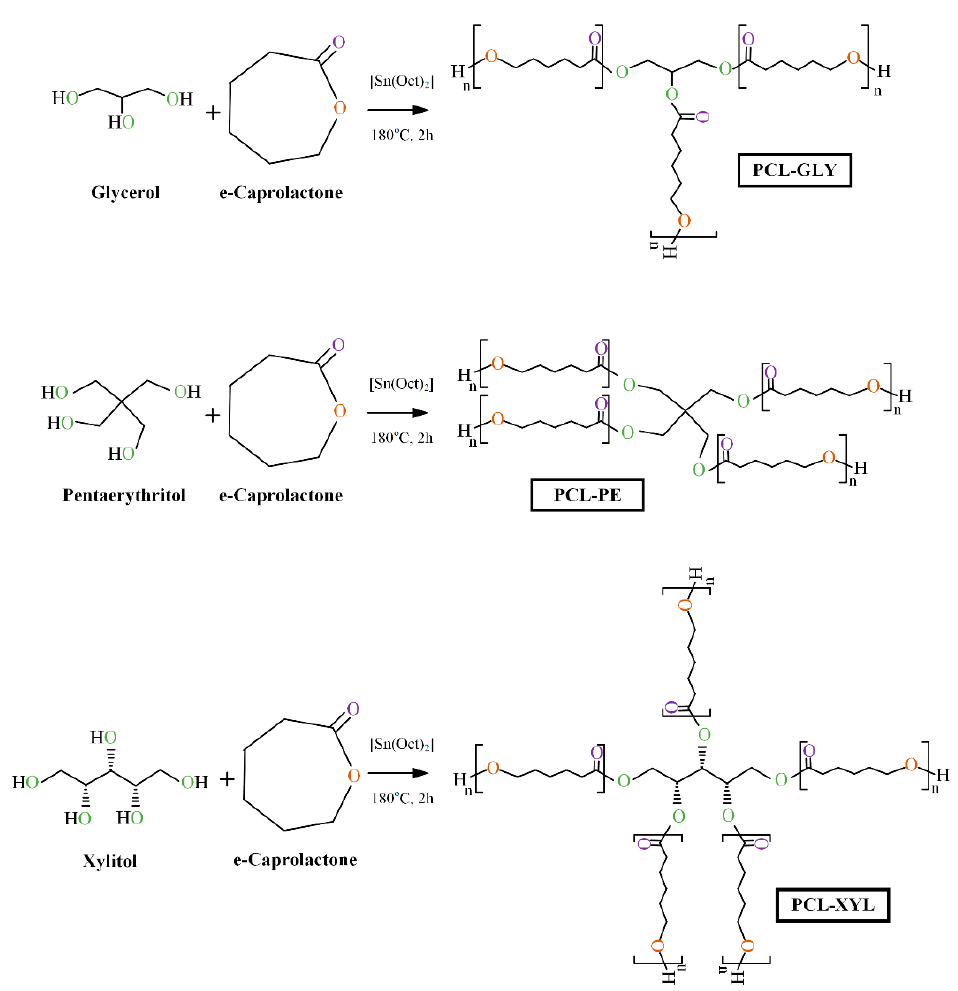
Scheme 1. Ring-opening polymerization (ROP) reaction scheme for the synthesis of the branched PCL-based copolymers with glycerol (GLY), pentaerythritol (PE), and xylitol (XYL).